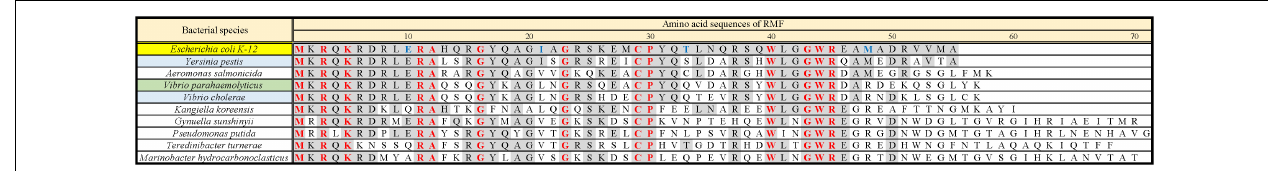
FIGURE 1 | Alignment of RMF amino acid sequences between 10 species of gammaproteobacteria. Completely conserved amino acids are represented in red. RMF of the E. coli strain used in this work is shown at the top with a yellow background. The representative pathogens, Yersinia pestis and Vibrio cholerae , are indicated by blue background. The structure of RMF (PDB ID: 2JRM) in Figure 6 and Supplementary Figure 6 is that of Vibrio parahaemolyticus , which is shown with a green background. Incompletely conserved amino acids were used as references and are shown in blue characters in the E. coli sequence (top line). The alignment from 50 bacteria is shown in Supplementary Figure 1